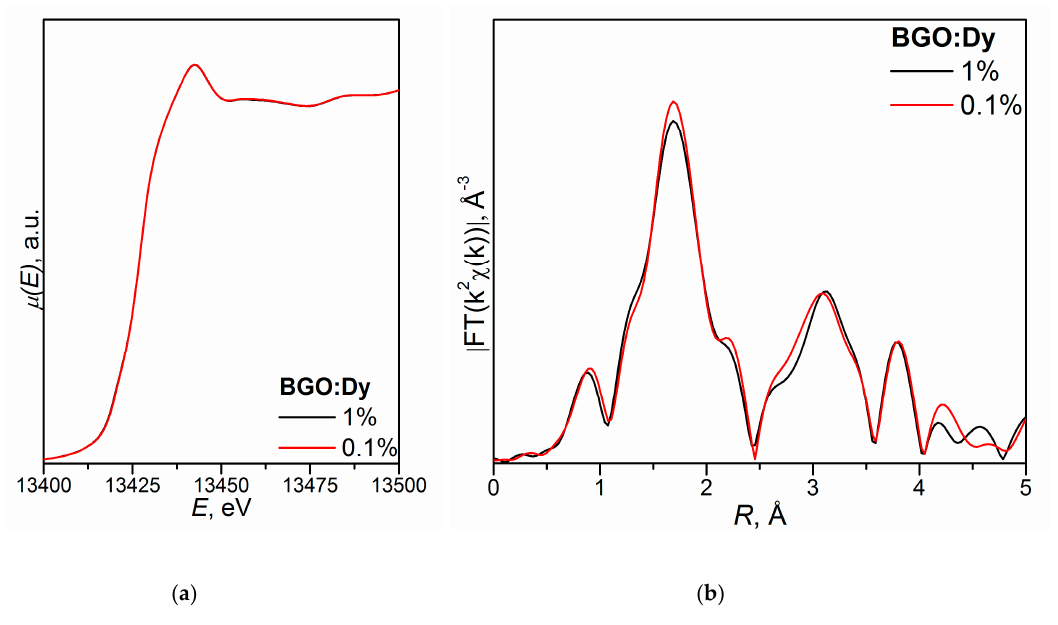
( b ) Figure 10. Model of rearrangement of ( а ) the BiO 6 and DyO 6 octahedra into ( b ) the vacancy BiO 5 octahedron and DyO 7 octahedron with a split top. The solid arrow shows the direction of Dy 3+ displacement with the formation of the DyO 7 polyhedron. The dashed arrow shows the direction of Dy 3+ displacement o with the formation of the DyO 5 polyhedron. A change in the Dy 3+ coordination polyhedron in the BGO:1.0Dy structure follows from the Dy L 3 -edge XANES spectrum (Figure 11).